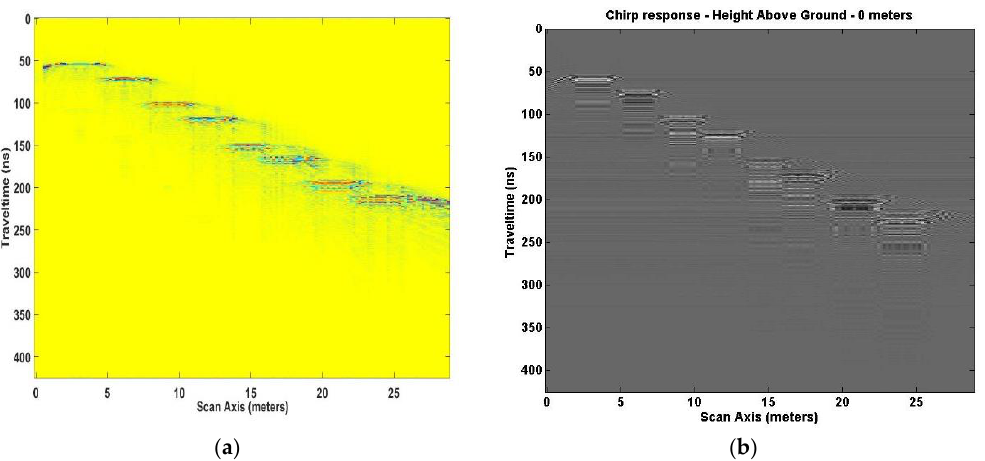
Figure 13. ( a ) Output response of SA2 model, EM sum of frequency signals with direct arrival and ground bounce signals removed [2 – 4]. ( b ) Output response of SA2 model, chirp excitation function with the direct arrival and ground bounce signals removed.